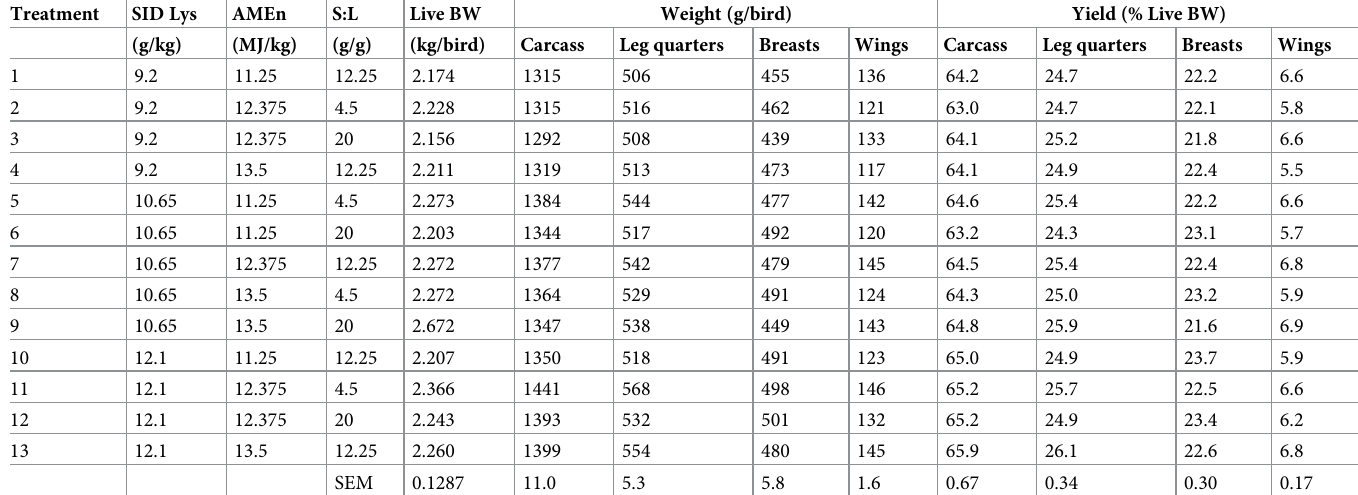
Table 7. Effects of dietary treatment on slaughter live body weight (BW) and carcass traits in broiler chickens at 35 days post-hatch. Treatment